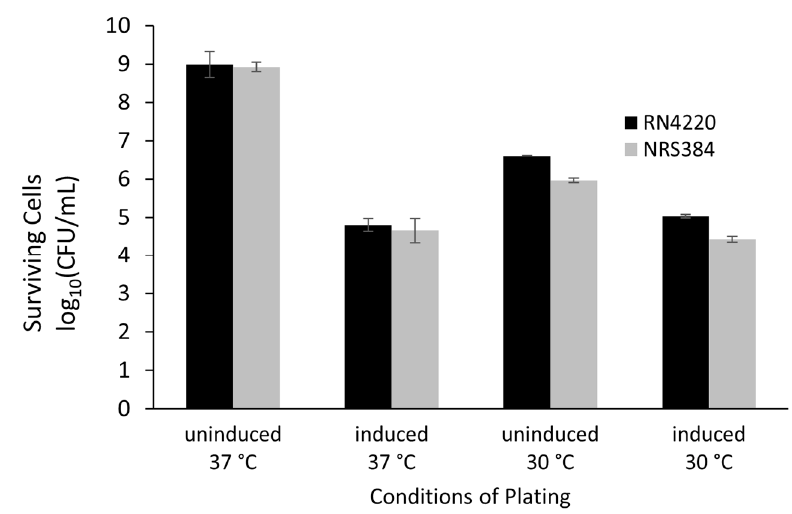
Figure 6. Surviving S. aureus cells when a 16 h broth culture of transformed cells is dilution plated at two temperatures in the presence or absence of arsenite, used to induce expression of phage K gp102 . Values are the mean and standard deviation of log 10 -transformed data from three transformant colonies of each strain.